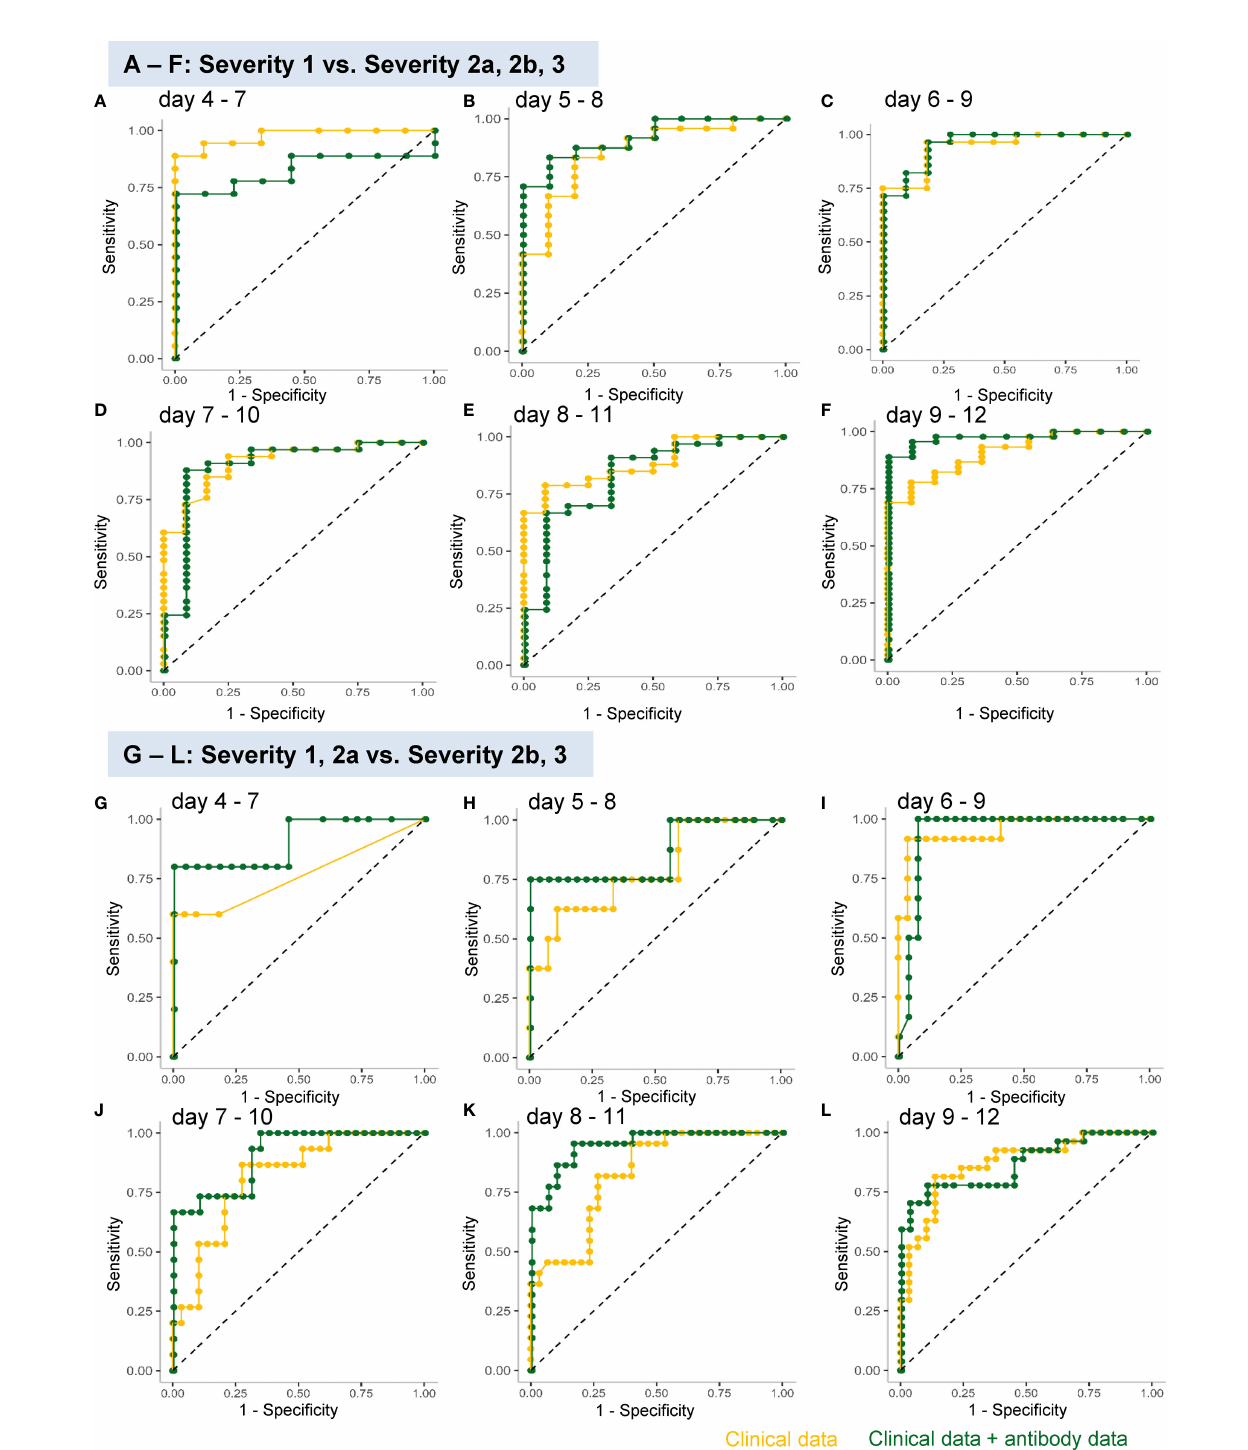
FIGURE 4 | ROC analyses of the analysis models constructed using a machine learning technique for predicting the maximum severity of COVID-19. The ROCs of the analysis models constructed using a machine learning technique for predicting the COVID-19 severity, using the data obtained on day 4 – 7 (A, G) , day 5 – 8 (B, H) , day 6 – 9 (C, I) , day 7 – 10 (D, J) , day 8 – 11 (E, K) , and day 9 – 12 (F, L) , are shown. The models were constructed to distinguish severity groups 2a or over from severity group 1 (A – F) or distinguish severity groups 2b and 3 from severity groups 1 and 2a (G – L) . The yellow curves represent the ROCs of the model constructed using clinical parameters and the green curves represent those of the model constructed using both clinical and antibody